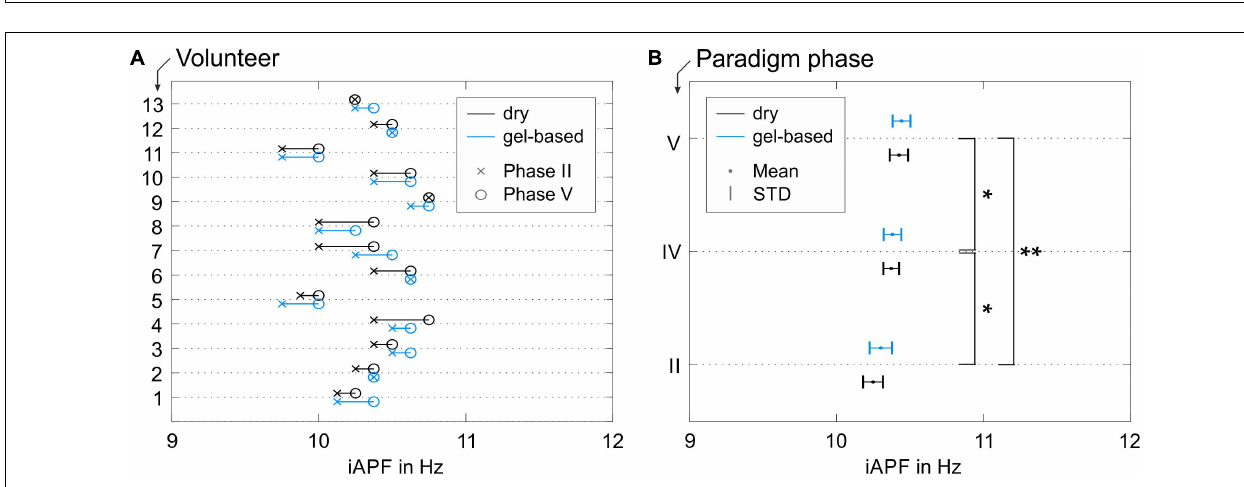
FIGURE 5 | The grand average PSD of the EEG segments recorded with the gel-based and dry electrode caps during (A) Phase I with open eyes, (B) Phase I with closed eyes, and (C) Phase V. Solid lines indicate mean over all volunteers, and dotted lines represent the corresponding STD.